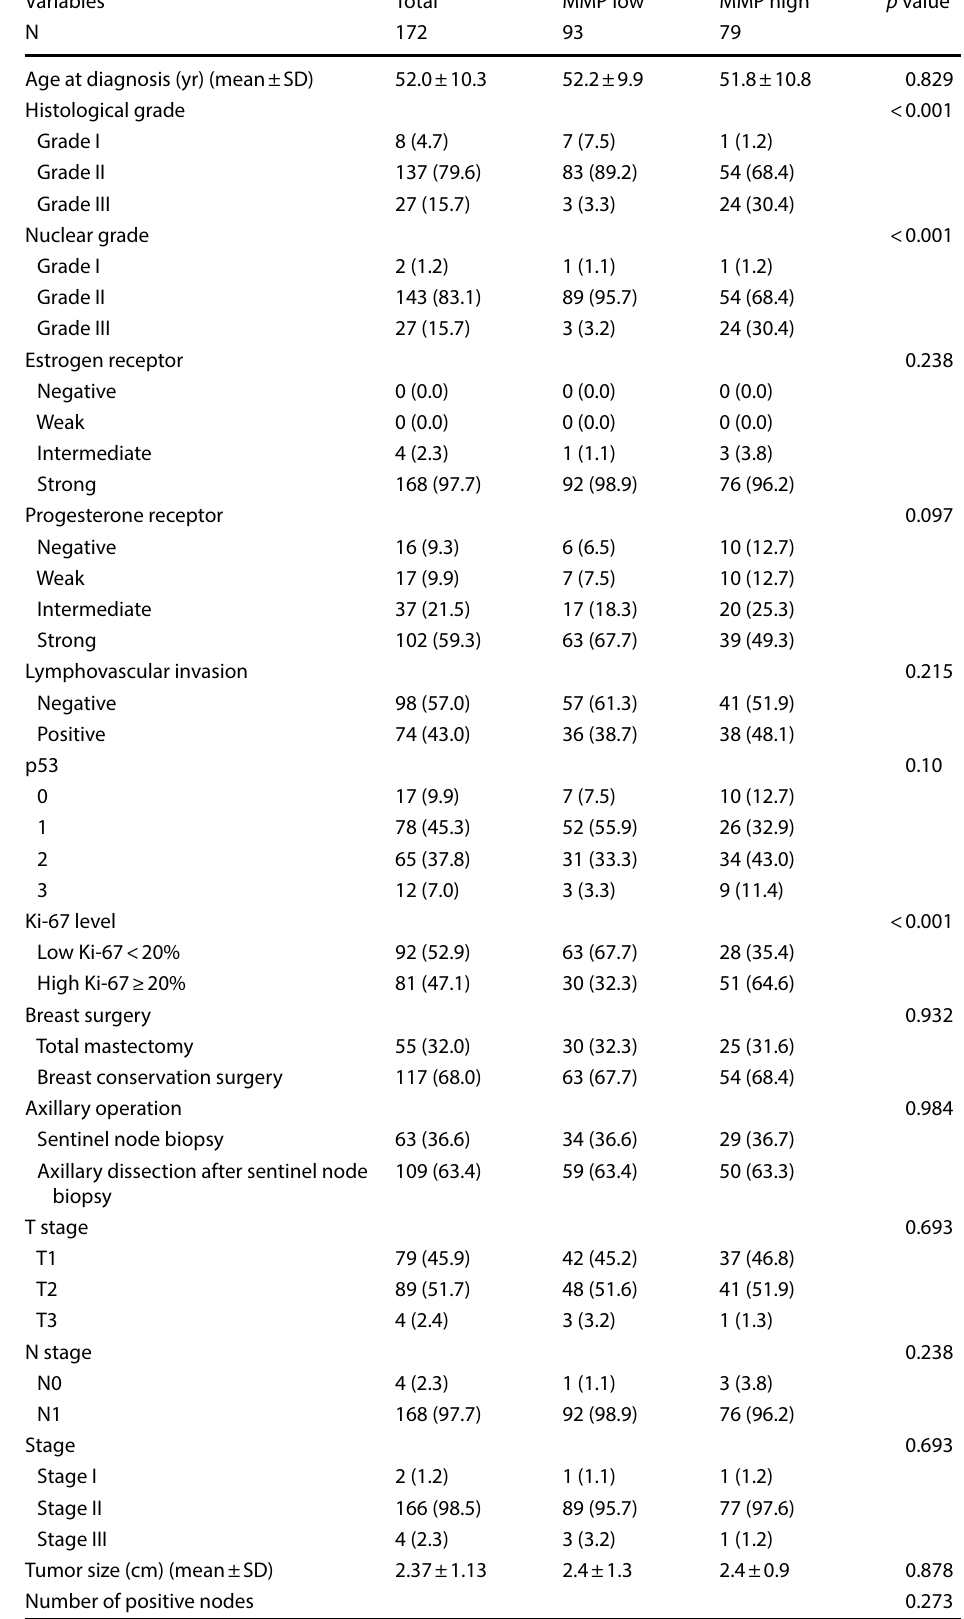
Table 1 Comparison between the characteristics of MMP low-risk and MMP high-risk patients with those of the total validation set 1 patient